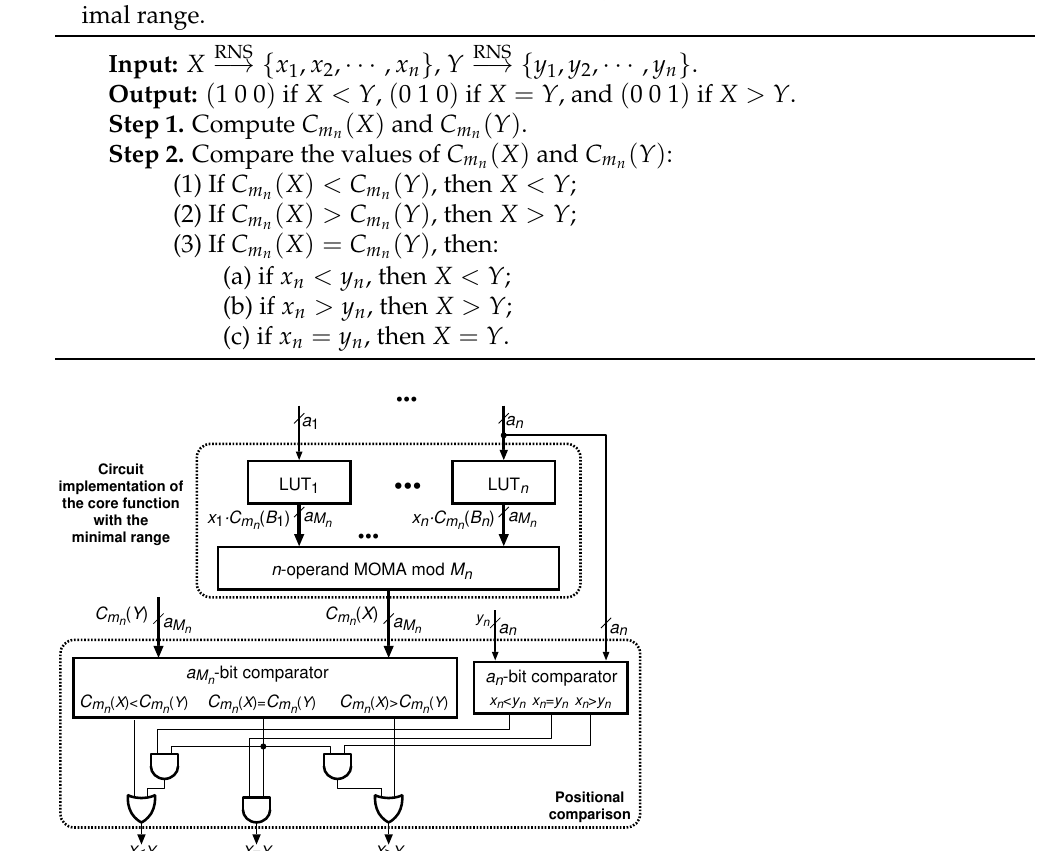
Figure 1. Hardware implementation of residue number system (RNS) numbers comparison